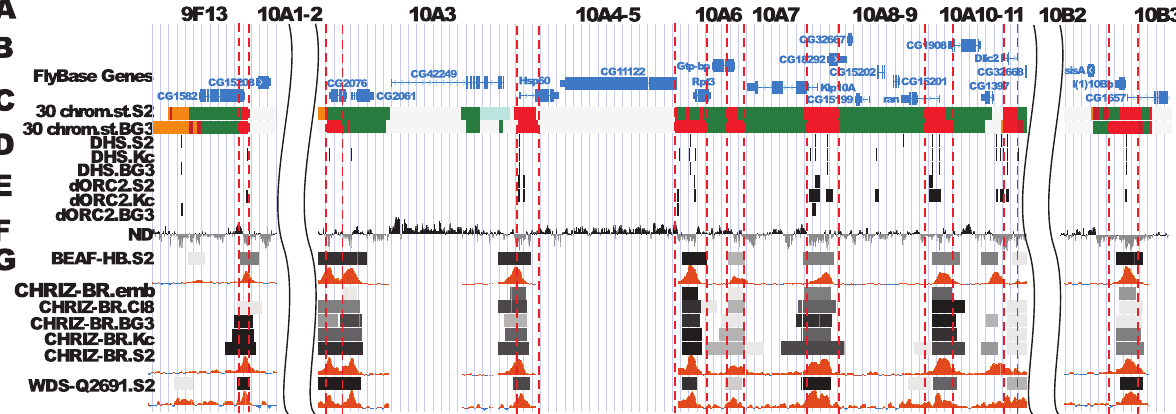
Figure 6. Relation of genetic map, and band/interband pattern in the region 9F13 – 10B3. A - predicted bands B - FlyBase genes C – 30 chromatin states in BG3 and S2 cells [48] D - DNase I hypersensitivity sites (DHS) in S2, BG3 and Kc cells [48] E - ORC-binding sites in S2, BG3 and Kc cells [59] F – Nucleosome Density (modENCODE, Henikoff group) G - active chromatin specific [48] and - interbands specific proteins. Predicted interbands (dotted vertical lines are according to peaks in distribution of corresponding elements, solid lines reflect the edges of distributions of different characteristics).